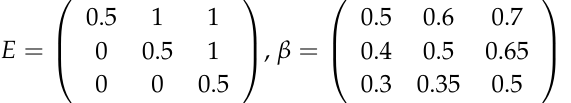
Table 8. The connection degrees between index j and level I–V (2015).